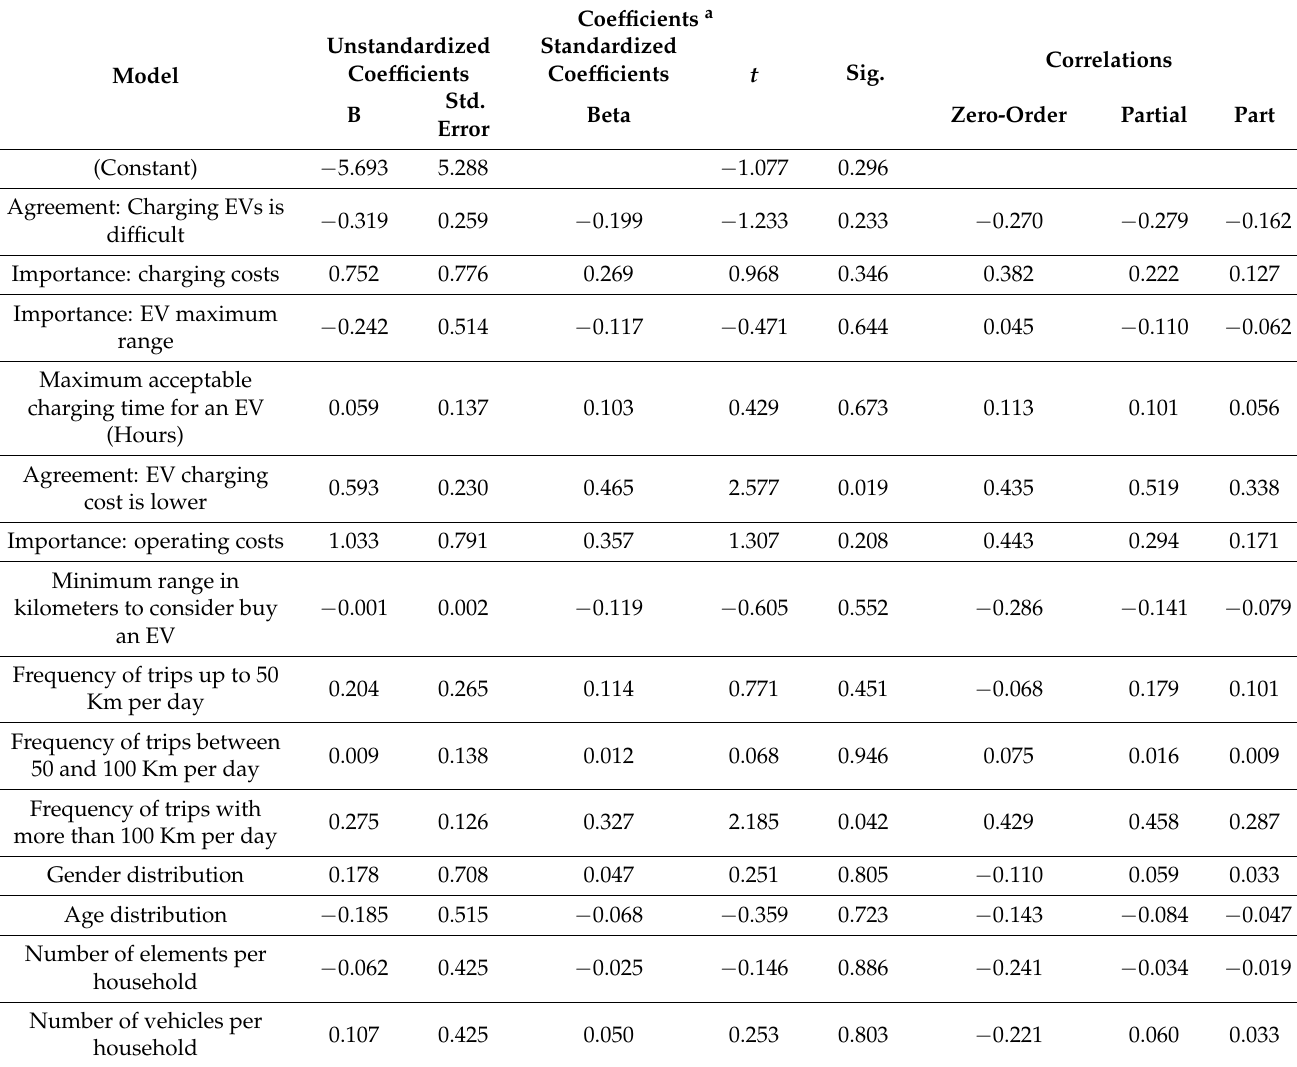
Table 12. Coefficients table—Importance of having a shared charging